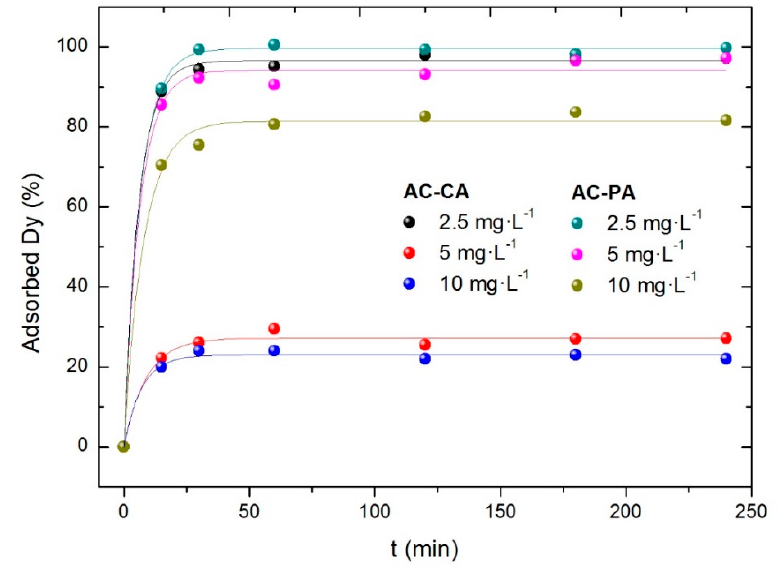
Figure 6. E ff ect of the dysprosium concentration in the adsorption Figure 6. Effect of the dysprosium concentration in the adsorption percentage.